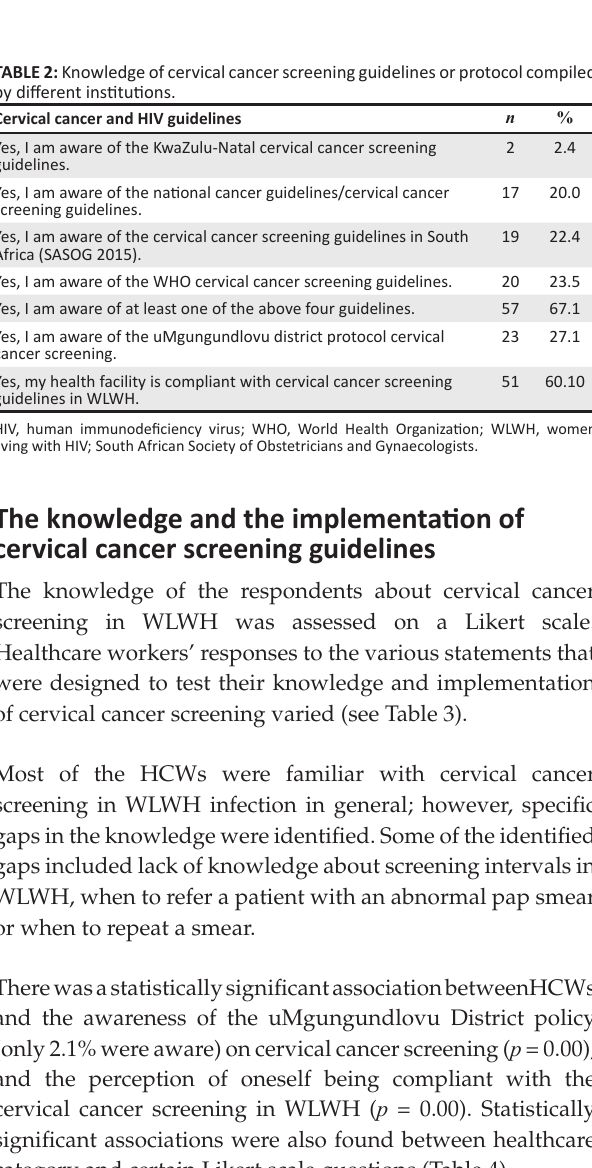
(Table 1). Of the 19 HCWs who had formal training in HIV